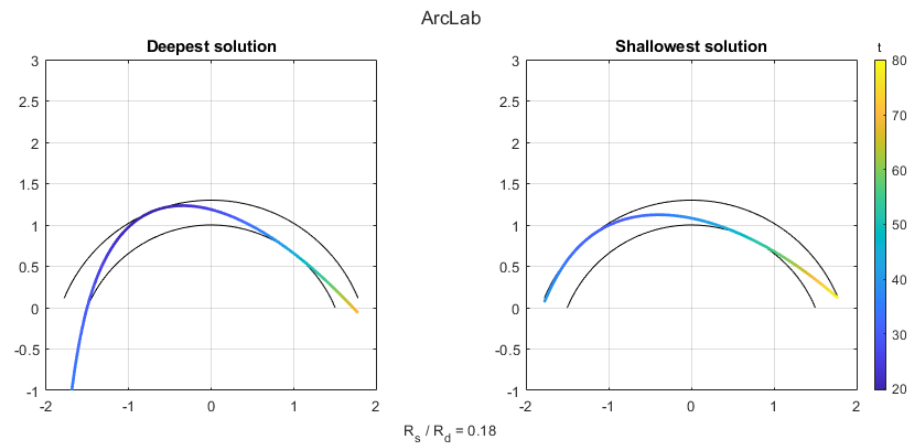
Figure 9: Deepest and shallowest solutions for a lowered arch subjected to vertical and horizontal loads